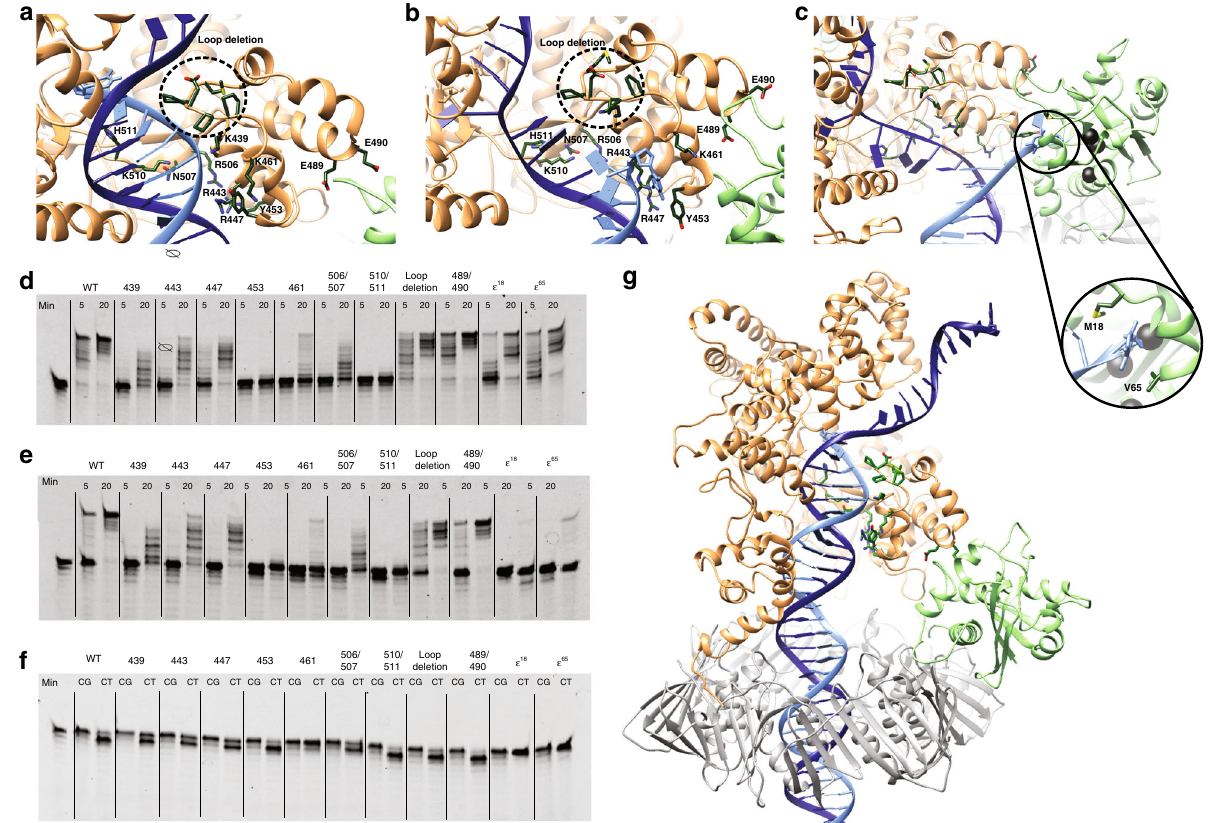
Fig. 6 Residues experimentally determined to be critical for transfer of DNA primer strand from polymerase to exonuclease active site. a – c Close up of the transition path between polymerase and exonuclease active site in ( a ) polymerase mode, ( b ) intermediate mode, and ( c ) exonuclease mode. Polymerase is colored in orange, exonuclease in green, template DNA strand in dark blue, and primer strand in light blue. Mutated residues are shown in dark green sticks. d Denaturing gel analysis of polymerase activity of wild type and mutant proteins on matched DNA. Mutants showing W-T activity are highlighted in green, mutations that are moderately affected in orange, and mutations that render the protein inactive in red. e Similar analysis using a DNA substrate with a terminal C – T mismatch. f Exonuclease activity on matched (C – G) and mismatched (C – T) DNA measured in the same DNA substrates as in panels d and e in the absence of nucleotides. g Overview of Pol III core complex in polymerase mode. The mutated residues are highlighted in dark green and the β -clamp in gray. The experiments in panels d , e have been reproduced more than three times, the experiment in panel f have been reproduced (M18, V65, and F102; Fig. 5e) that transiently stabilizes the